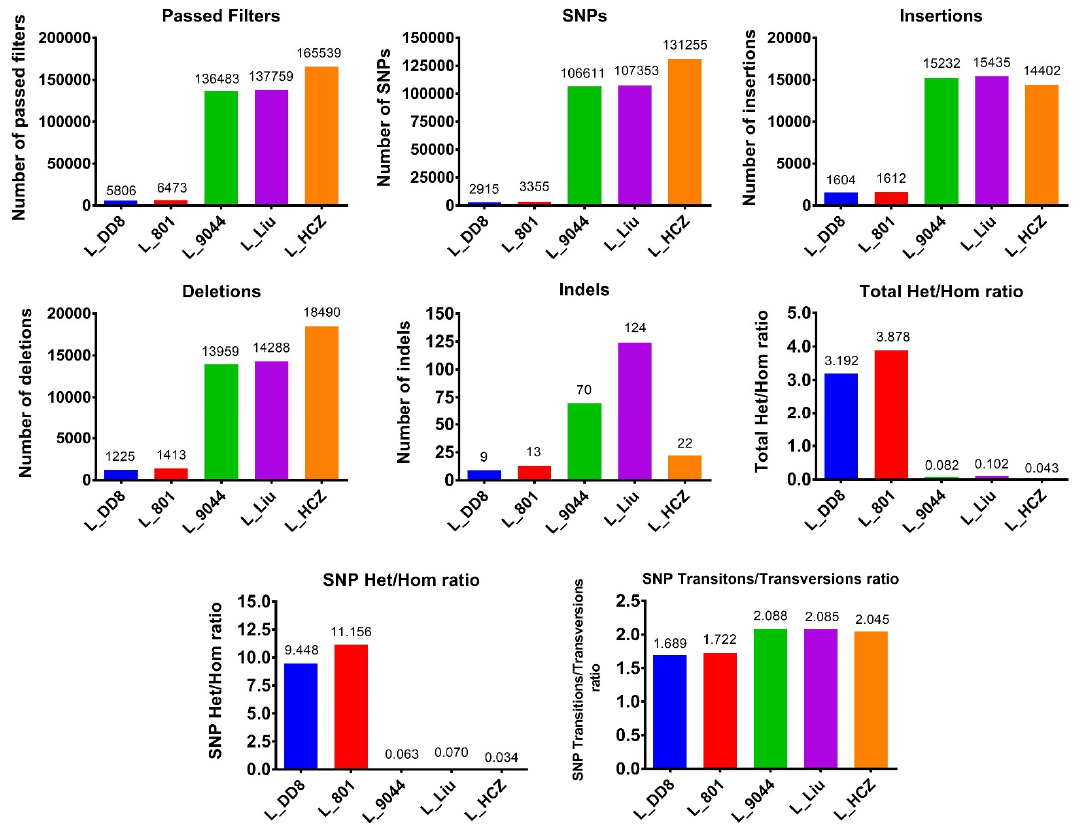
Figure 1. SNPs/InDels detection results. Passed Filters: variations verified by the GATK quality control process. InDels: Insertions/Deletions. Total Het/Hom ratio: the ratio of total heterozygous variation to homozygous variation. SNP Het/Hom ratio: the ratio of heterozygous SNP to homozygous SNP. SNP Transitions/Transversions: the ratio of SNP transitions to transversions. The distribution of SNPs and InDels of the five Leishmania isolates is shown in Figure 2. Similarly, the distribution of SNPs and InDels of L_801 and L_DD8 was different from that of the other three isolates. The SNPs and InDels of L_801 and L_DD8 were mainly distributed upstream and downstream of genes, followed by the exonic region. However, the SNPs and InDels of L_9044, L_Liu and L_HCZ were most distributed in the exonic region, followed by upstream and downstream of genes, and their distribution in the up- stream and downstream of genes was roughly the same. Only a very small number of SNPs and InDels in the five Leishmania isolates was distributed in the exonic region of ncRNA and the 5 ′ UTR region. It is worth noting that none of the five Leishmania SNPs and InDels were distributed in intronic, ncRNA_intronic, 3 ′ UTR and splicing regions.